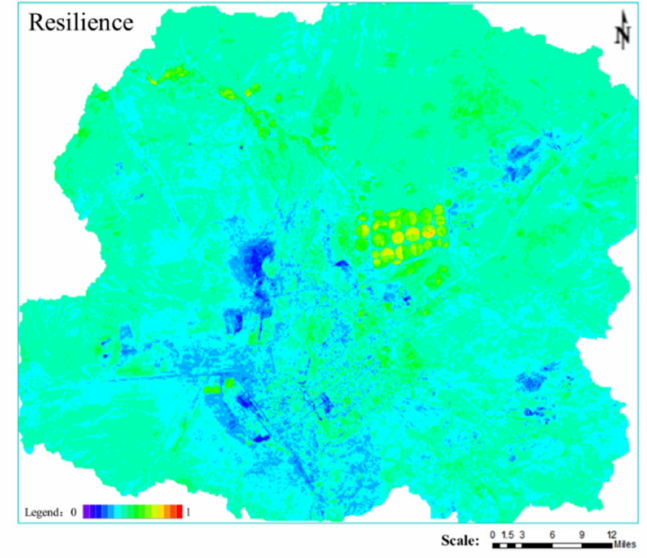
Figure 7. Spatial distribution map of